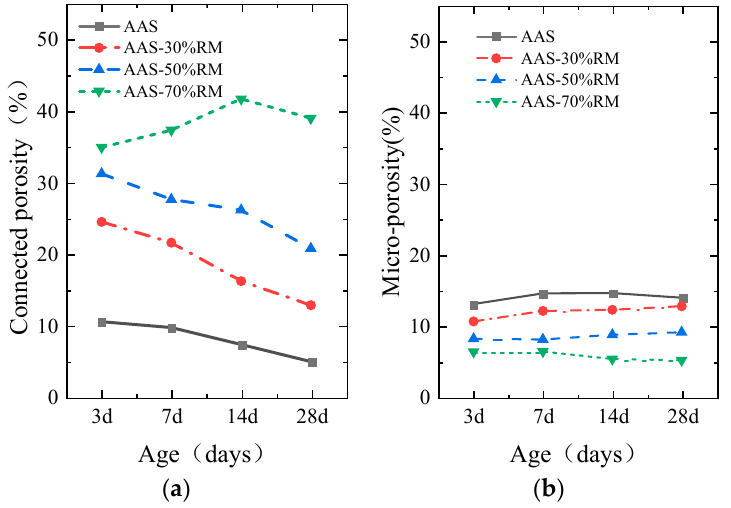
Figure 5. Connected porosity ( a ) and Micro-porosity ( b ) of AASR with different additions of RM.